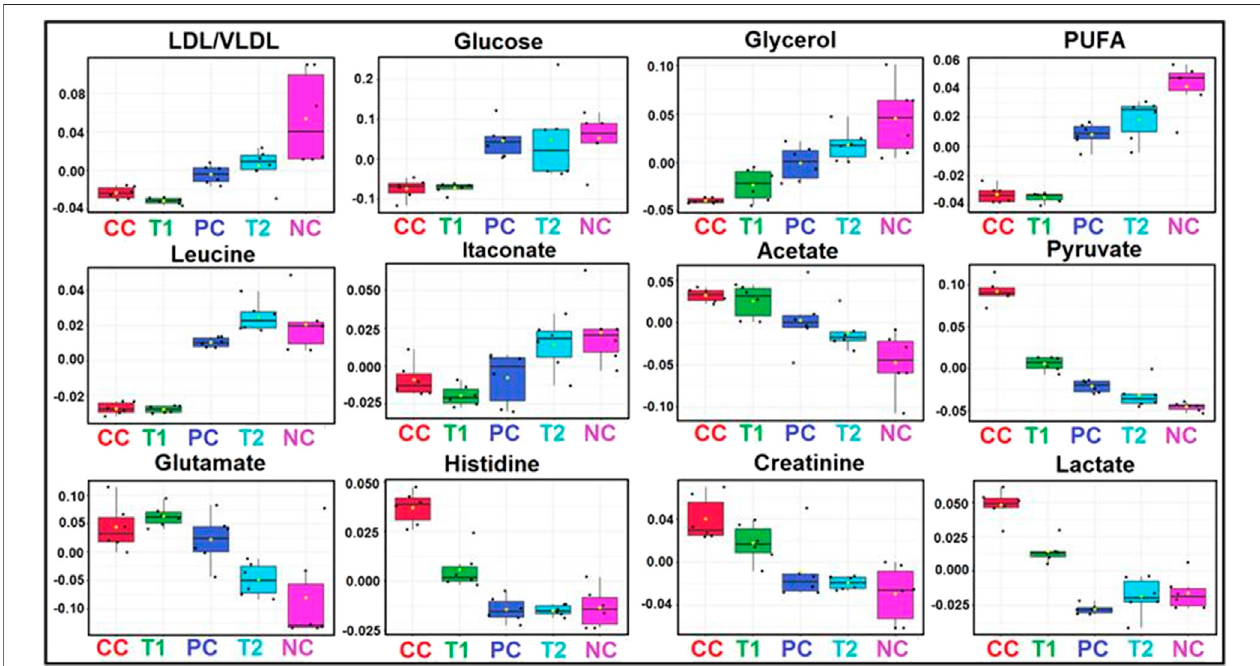
FIGURE6| MetaboliceffectsofDItreatment:Thebox-cum-whiskerplotsareshowingrelativevariationsinquantitativepro fi lesofserum metabolitesrelevantinthe context of the pathophysiology of hepatic cancer. In the box plots, the boxes denote interquartile ranges, horizontal line inside the box denote the median, and bottom and topboundaries ofboxesare25thand75thpercentiles,respectively.Lowerand upper whiskersare5thand 95thpercentiles, respectively.NC,NormalControl;CC, Carcinogen Control; PC, Positive Control; T1, DI (100 mg/kg) and T2, DI (200 mg/kg).